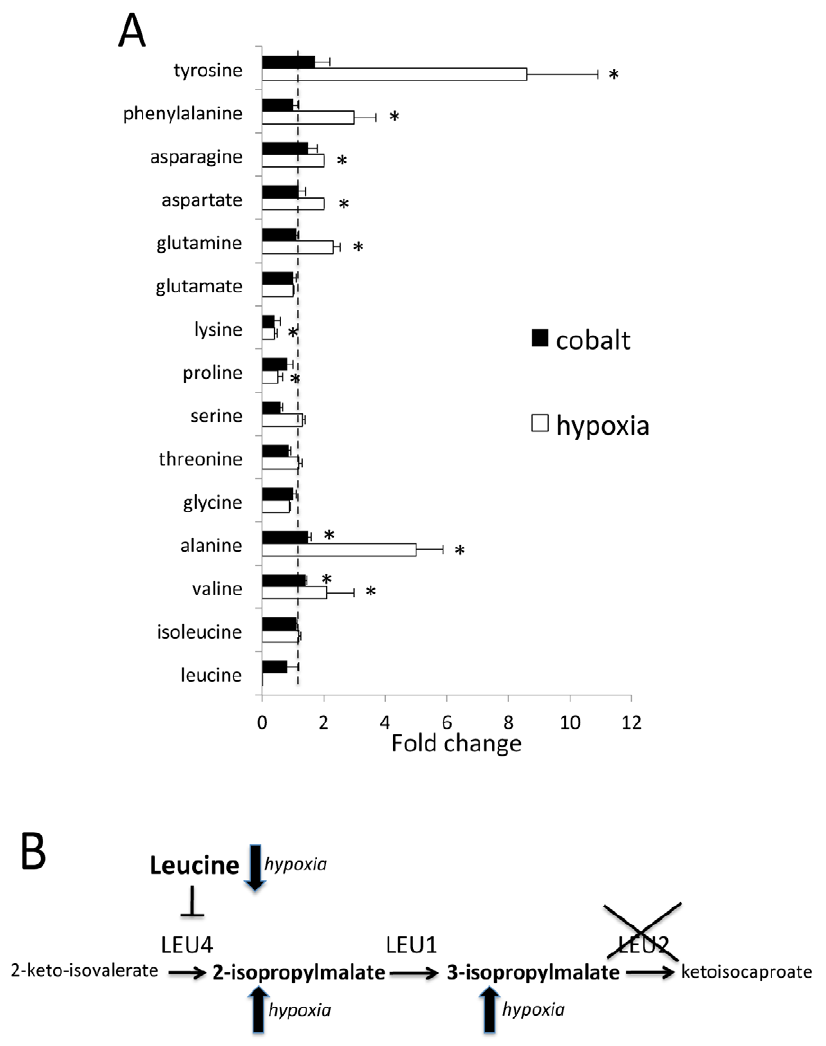
Figure 8. Effect of hypoxia on amino acids. A) Cells grown in minimal medium as in Fig. 1 were assayed for the designed amino acids by GC/MS. Statistically significant differences over control (P value =0.05) are designated with asterisks. Dotted line =1.0 value assigned to control. B) Segment of the leucine biosynthetic pathway involving Leu4p, Leu1p (IPMI) and Leu2p. The strain used in these studies contains a leu2 gene deletion designated by X. Arrows indicate the effect of hypoxia on leucine and the 2-IPM and 3-IPM precursors for leucine. Schematic depicts the negative feedback of leucine levels on Leu4p.